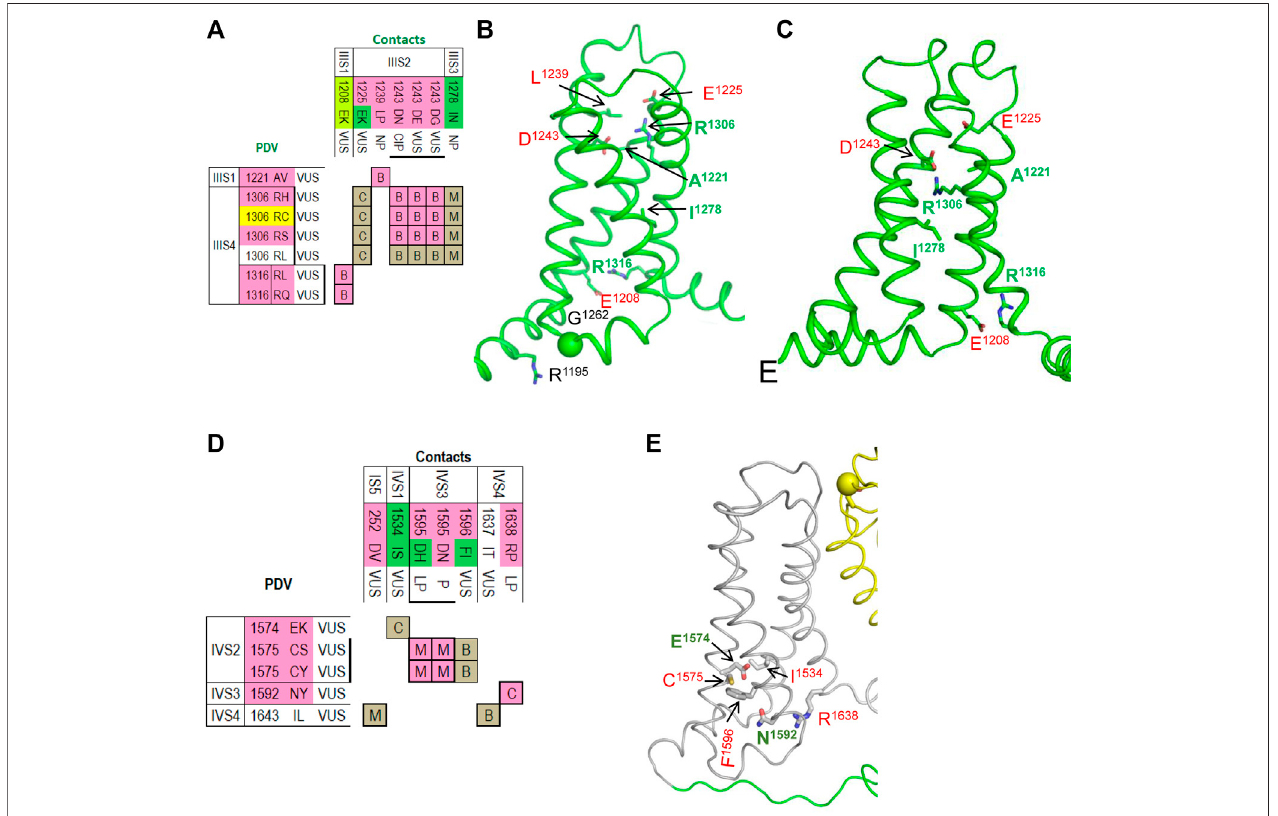
FIGURE7| Matrices ofcontact variants andstructuresofVSD-III and VSD-VI. (A) Matrix ofcontactvariants ofVSD-III. (B,C) VSD-III intheactivated-state cryo-EM structure (B) and resting-state model (C) . Residues from set w54 and their contacts are indicated with green and red labels, respectively. See section VSD-III for more detail. (D) MatrixofcontactvariantsofVSD-IV. (E )Activated-statestructureofVSD-IV.Residuesfromsetw54andtheircontactsareindicatedwithgreenandredlabels, respectively. See section VSD-IV for more details.